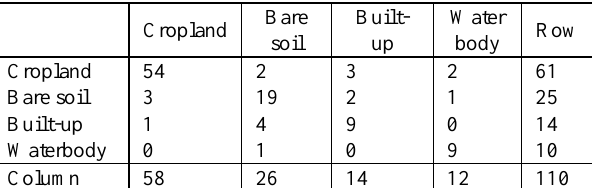
Table 3. error matrix of land cover classification.